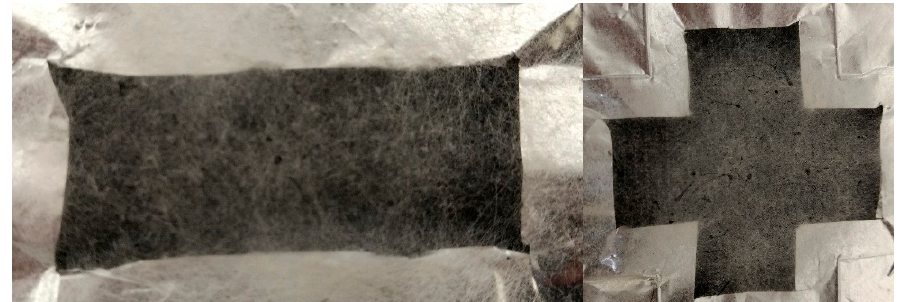
Figure 5. Experimental devices for nanofibers production.